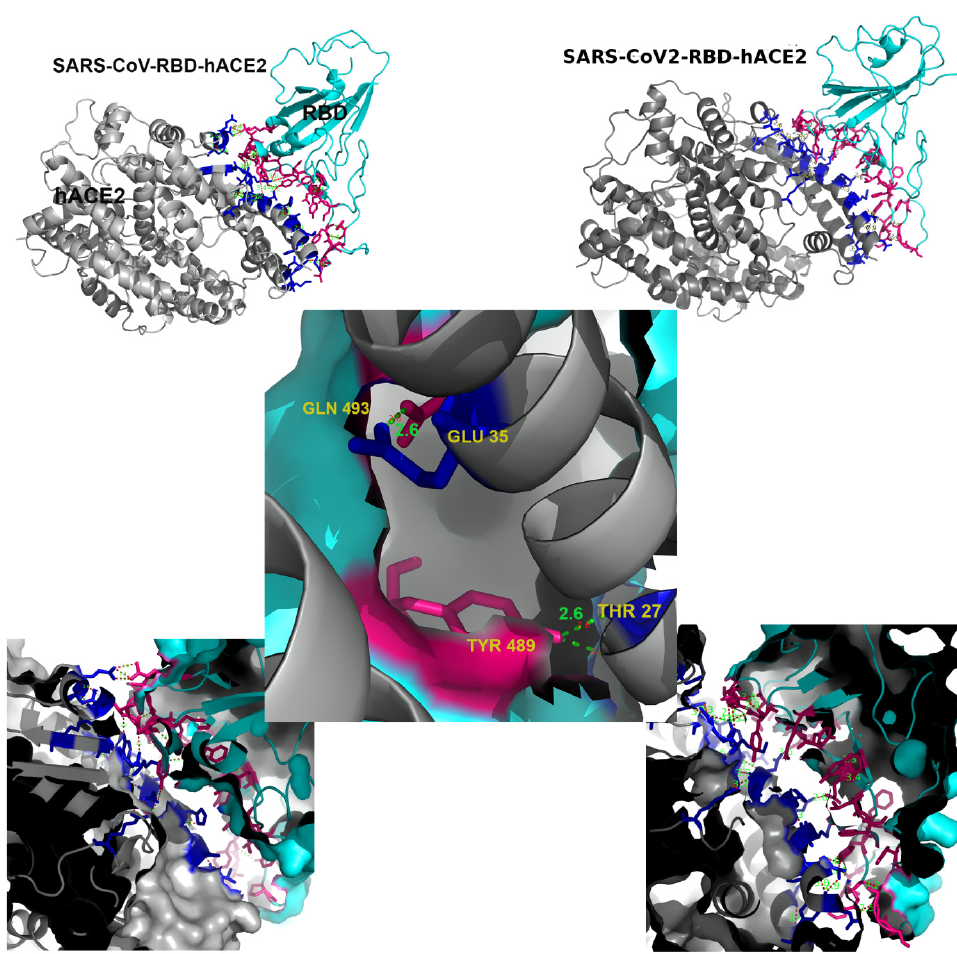
Figure 1. Interface interactions between CoV-1 and CoV-2 receptor-binding domain (RBD) and the hACE2. In both complexes, almost all interface molecular interactions involve loops and small parts of beta-sheets secondary structures of RBD and a single alpha helical structure of hACE2. The hACE2.GLU35– RBD.GLN493 and hACE2.THR27–RBD.TYR489 (2.6 Å) form H-bond interactions indicated by dashed lines. Pink and blue color represent RBD and hACE2 interfaces